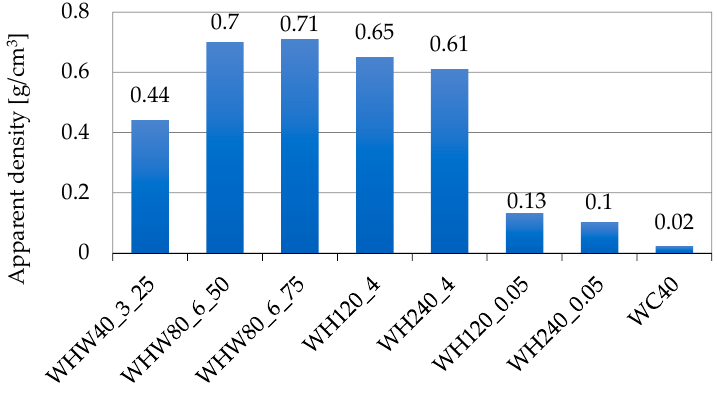
Figure 5. Apparent density values.